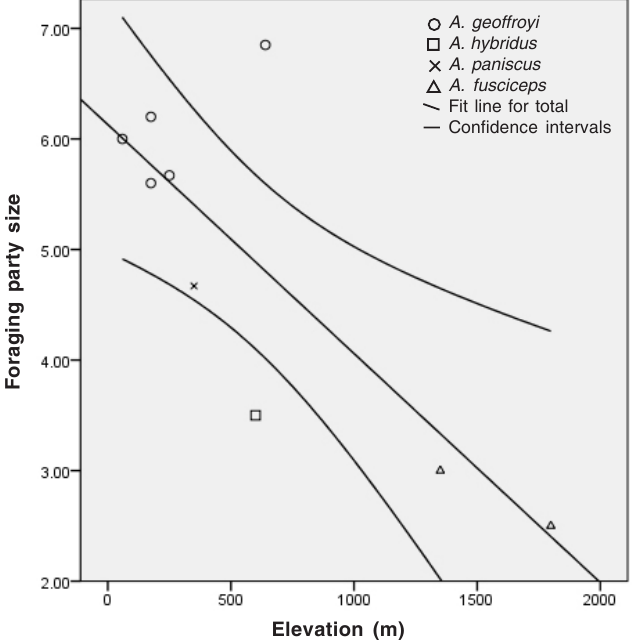
Figure 3. Regression of spider monkey foraging party size against